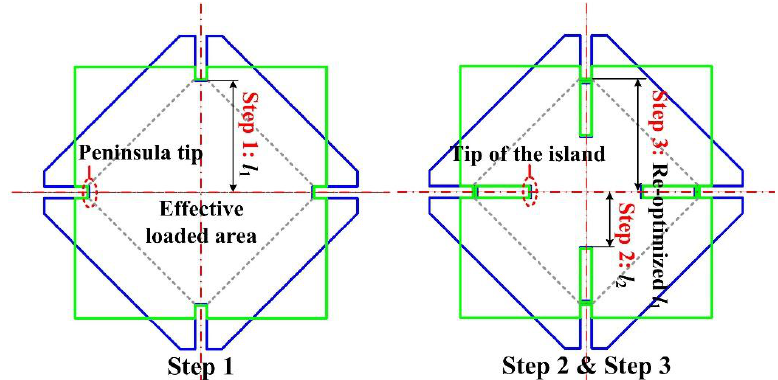
Figure 10. Optimization process of the peninsula-island structure for different distribution patterns.